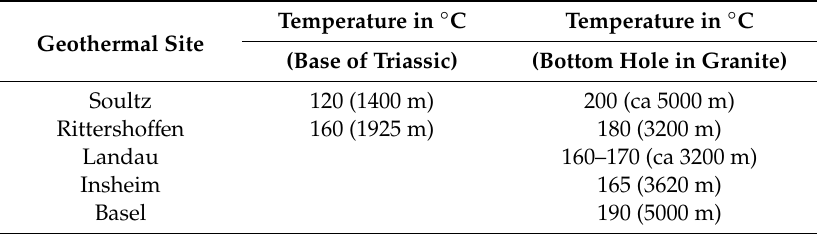
Figure 3. Thermal gradients in the sedimentary cover of the URG (modified after [10]). Data from Rittersho ff en geothermal wells (GRT-1 and GRT-2) and from oil wells (OBR, RT, HAT). Table 1. Temperatures measured in the drillholes of five geothermal sites in France (Soultz and Rittersho ff en), Germany (Landau and Insheim) and Switzerland (Basel), after [12,17]. For location map, see Figure